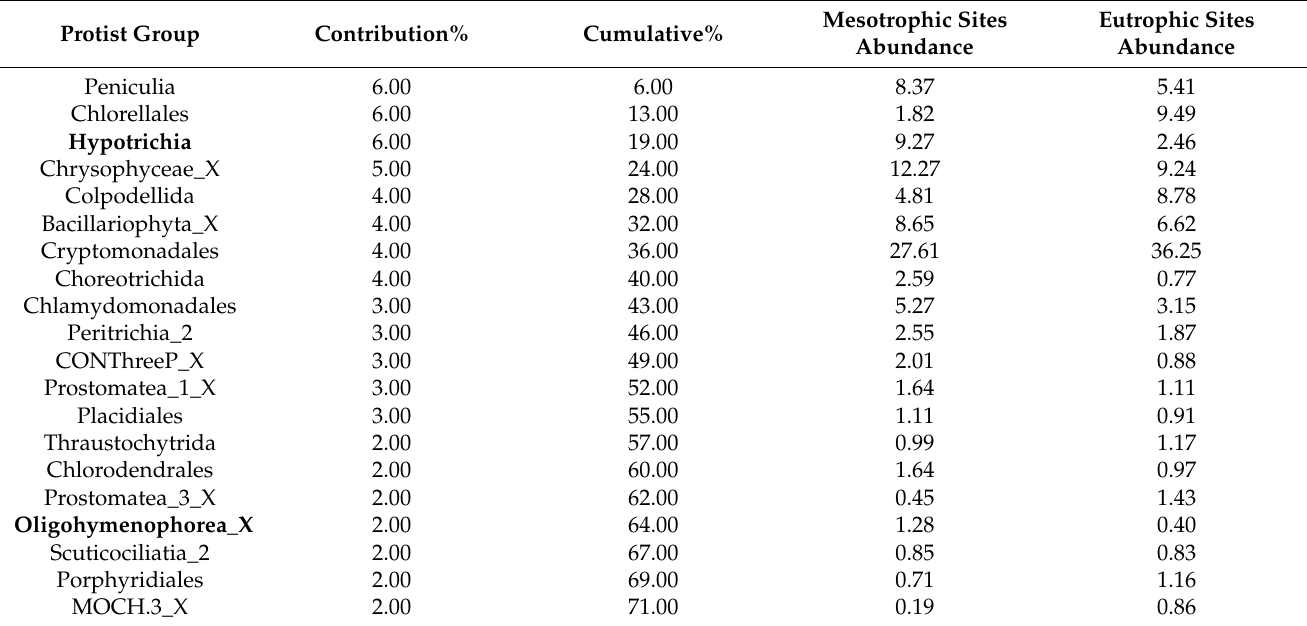
Table 2. Similarity percentage analysis to identify protist groups that best differentiated sites with mesotrophic and eutrophic trophic states during 5–10 October 2019, along the New River, Belize. Contribution percentage for each group and cumulative percentage (up to 70%) are shown. Average relative abundance of protist groups is shown for mesotrophic and eutrophic sites. Groups with significant contributions to dissimilarities are in